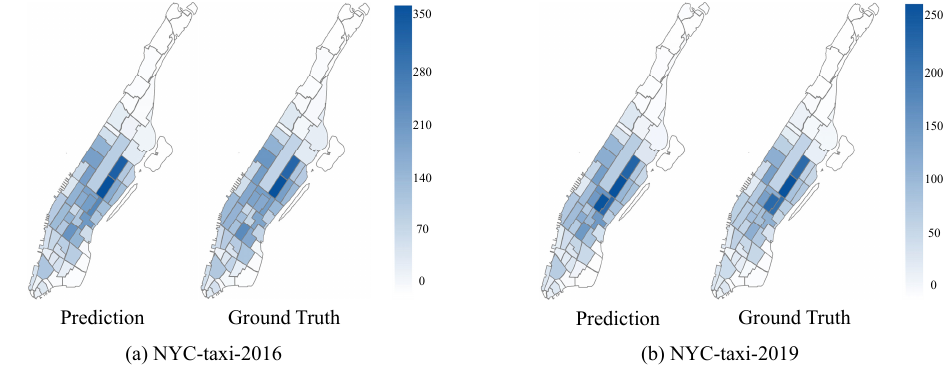
Figure 13. Visualization of travel demand for 15 min in all regions on two